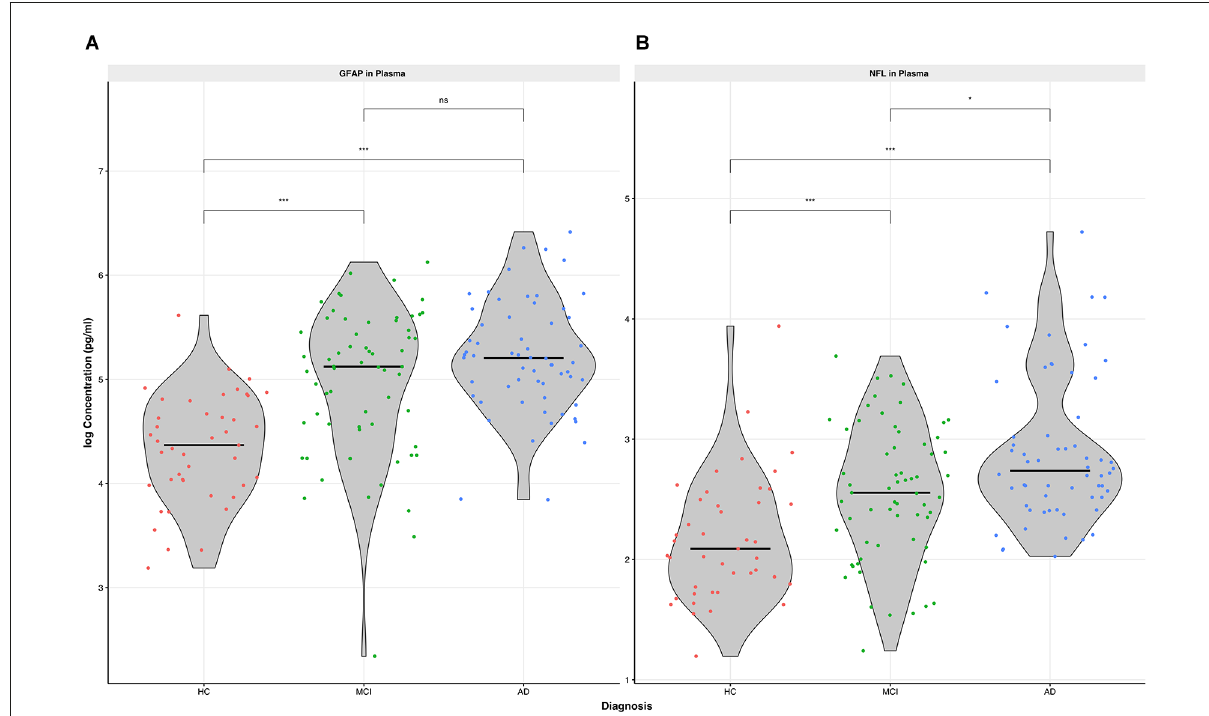
FIGURE1 Concentration of GFAP (A) and NfL (B) in plasma among the three cohorts (HC, MCI, AD). Differences of biomarker concentration were calculated using Kruskal-Wallis Test, p value is displayed as * p < 0.05, *** p < 0.001, ns , not significant. HC , healthy controls; MCI , mild cognitive impairment; AD , Alzheimer’s disease; CSF , cerebrospinal fluid; NfL , neurofilament light chain; GFAP , glial fibrillary acidic protein.